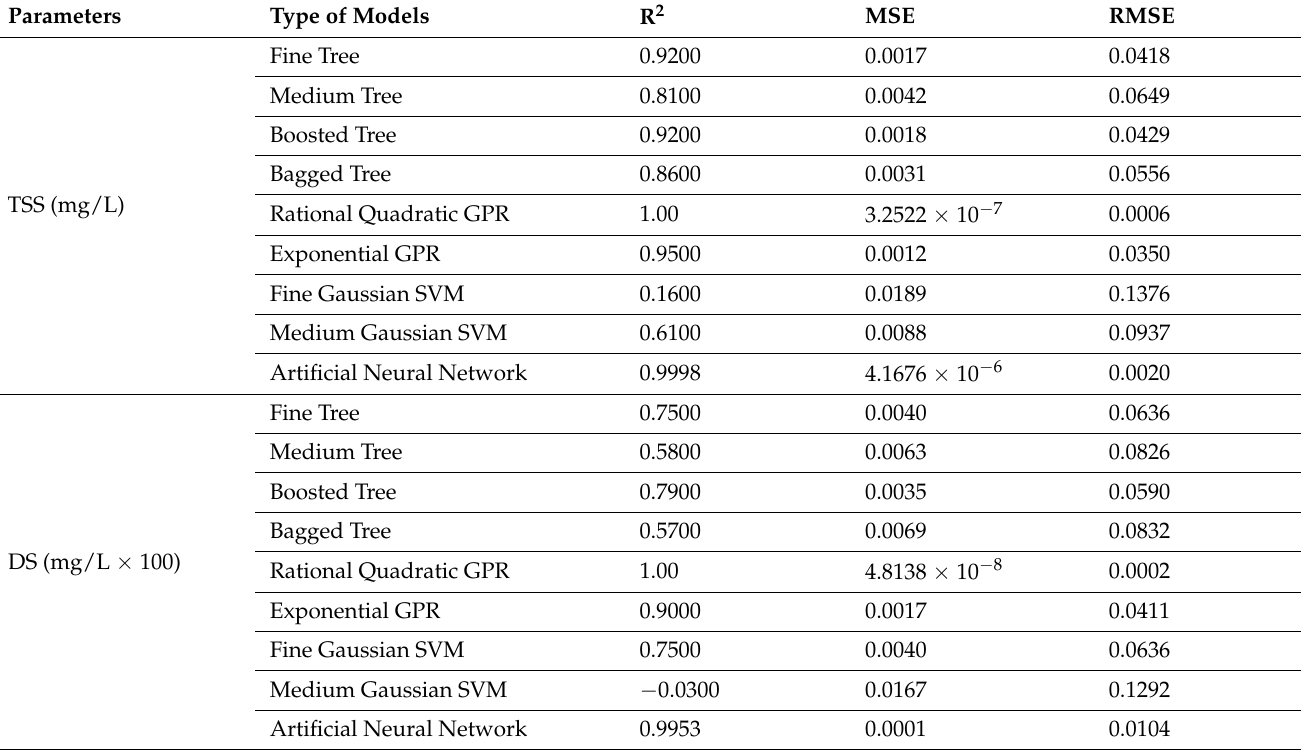
Table 4. Prediction analysis of all parameters (overall